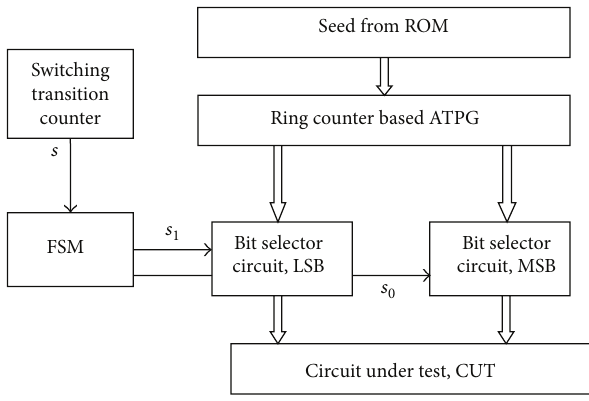
Figure 1: General architecture of the proposed method.